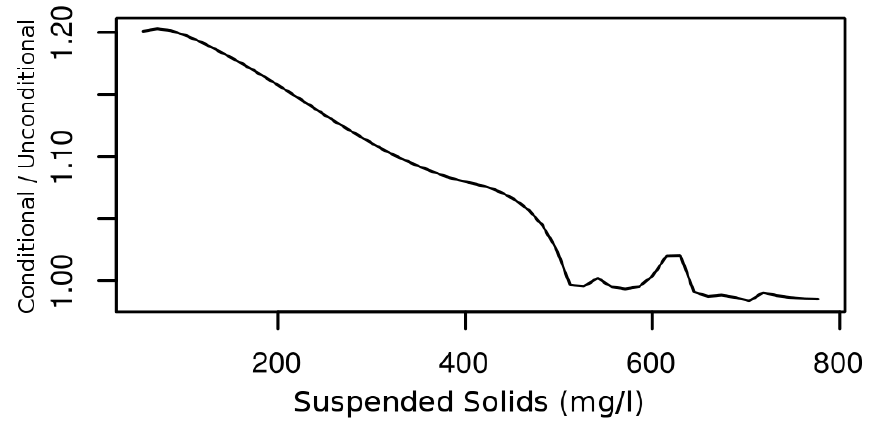
Figure 2. Partial regression plot of SS (mg/L).